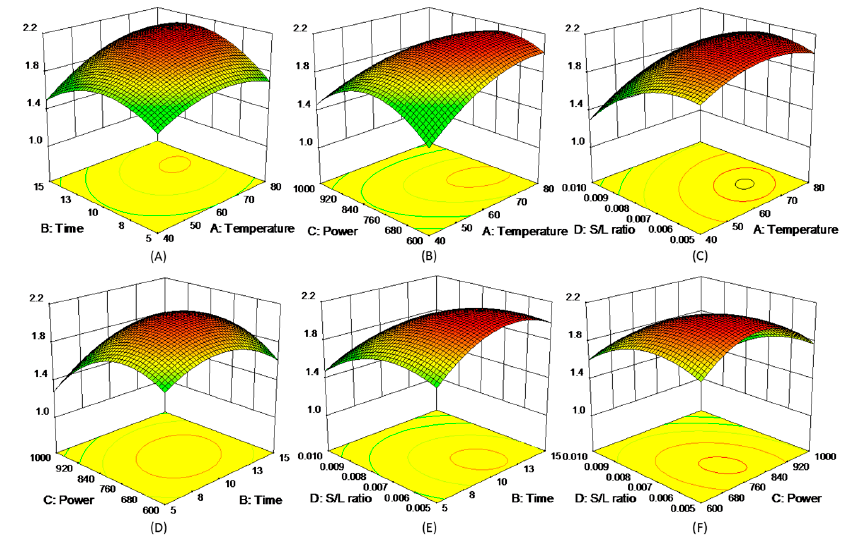
Figure 6. 3D response surface plots of SAA.